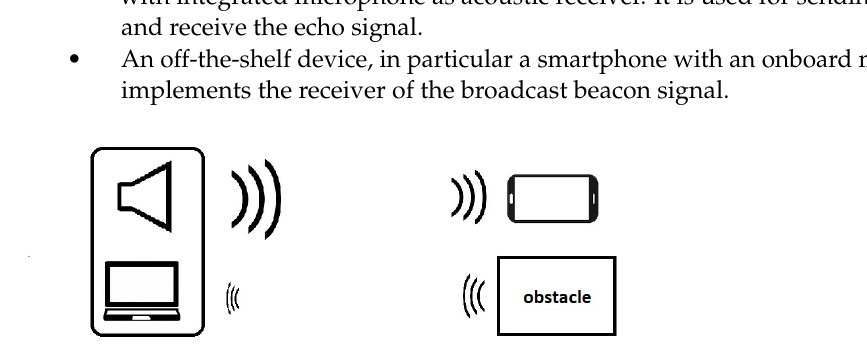
Figure 4. Experimental setup for acoustic dual-function communication and